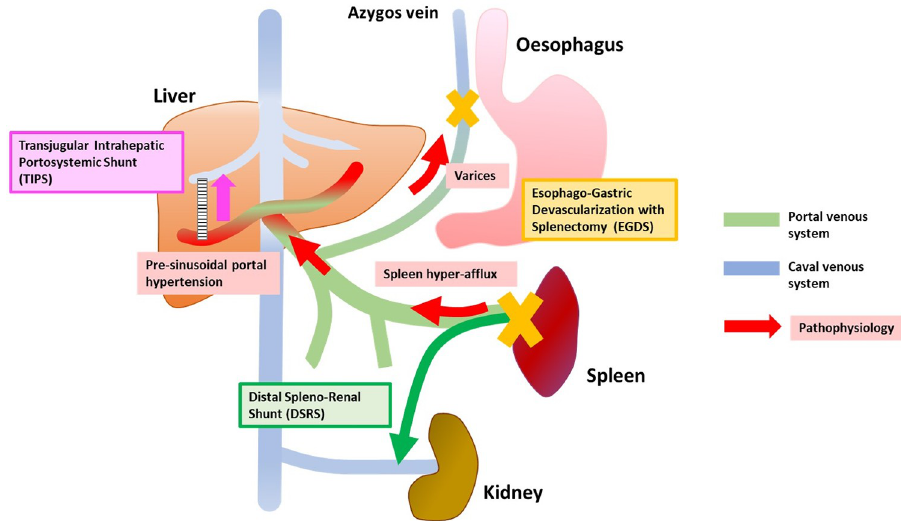
Fig 1. Schematic representation of the main pathological mechanisms of HSS (red arrows and boxes) and of the main surgical approaches (Edged colored boxes). The chronic granulomatous reaction around Schistosoma spp. eggs embolized in the liver eventually results in presinusoidal portal hypertension, which in turn causes spleen congestion and the formation of varices. Portal hypertension is also supported by spleen hyperafflux. Hepatopetal portal flow is generally preserved. The “classical” surgical interventions for HSS include EGDS and DSRS. TIPS shunts the portal blood flow intrahepatically from the portal to the hepatic venous system. DSRS, distal splenorenal shunt; EGDS, esophagogastric devascularization procedure with splenectomy; HSS, hepatosplenic schistosomiasis; TIPS, transjugular intrahepatic portosystemic shunt.